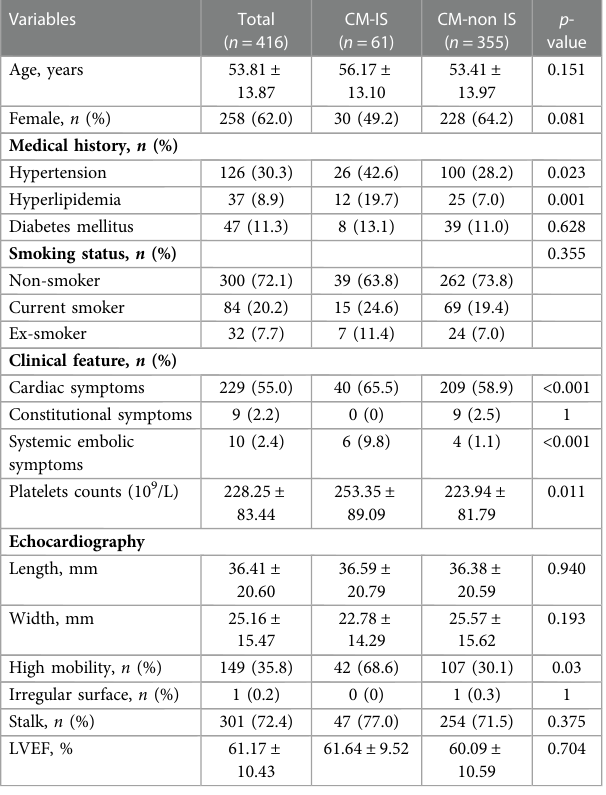
TABLE 1 Baseline characteristics of patients with cardiac